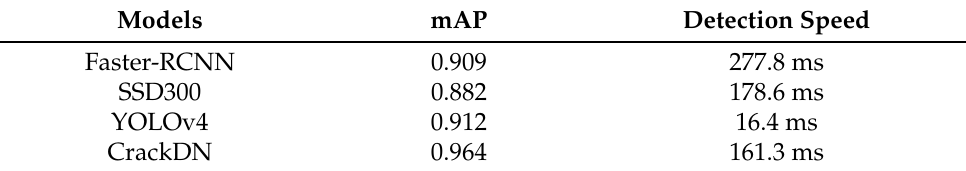
Table 6. Metrics comparison.